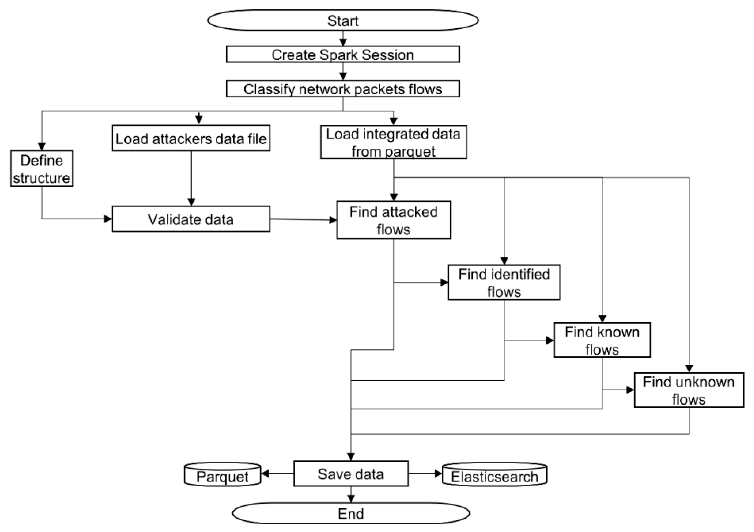
Figure 9. Design of network packets flow classification component.